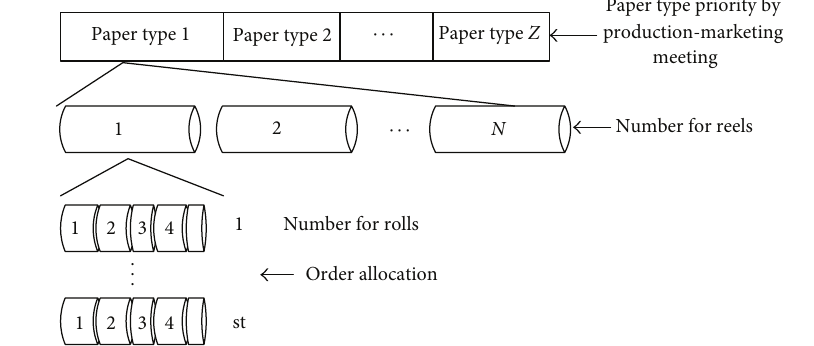
Figure 1: Production planning in the paper industry.